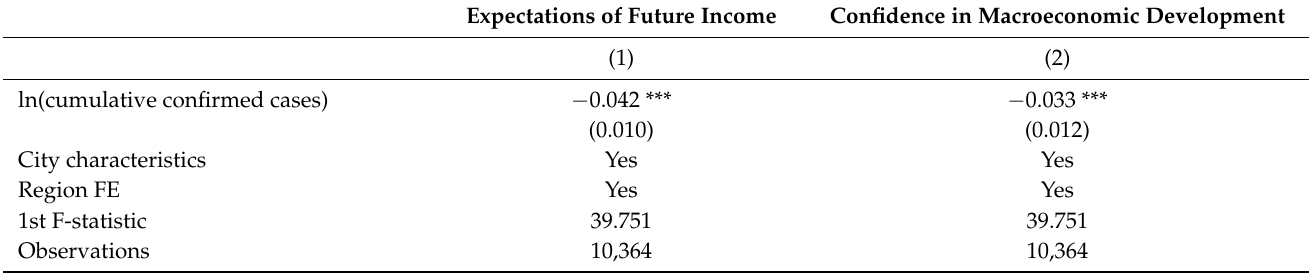
Table 5. Mechanism